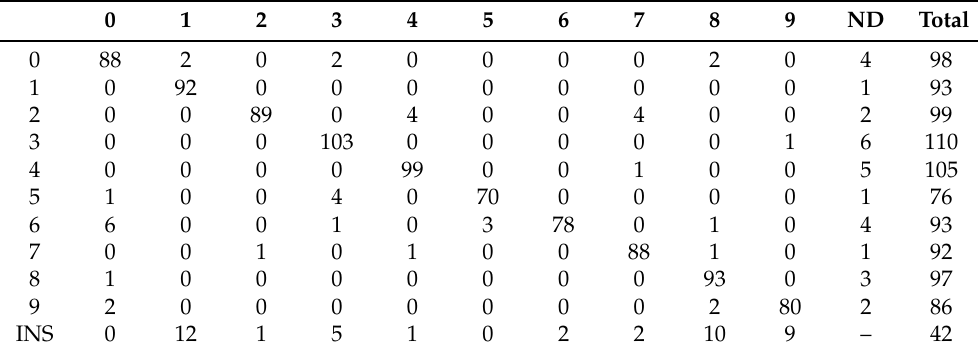
Table 6. Confusion matrix for Corpus 2 (INS—segment incorrectly recognized as a digit; ND—digit not